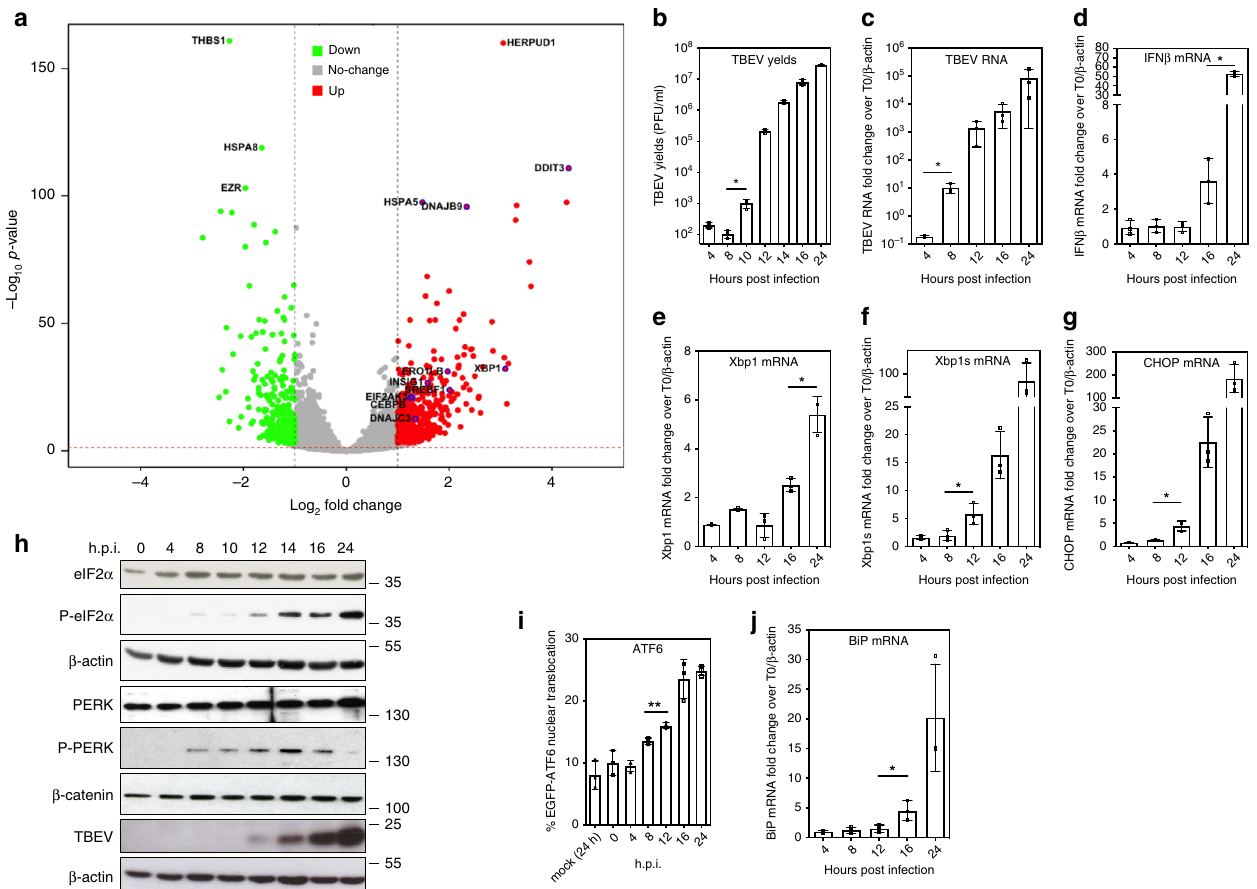
Fig. 1 Temporal analysis of the UPR response to TBEV infection. a Difference in total transcript expression following TBEV infection. Total RNA was extracted from TBEV infected cells at 0, 10, and 24 h.p.i. in triplicate independent experiments and processed for high-content sequencing ( ∼ 24.6 million reads for each time point). The volcano plot shows the differential gene expression at 24/0 versus 10/0 h.p.i. Horizontal and vertical dashed lines indicate cutoff values (FDR value of 0.05 corresponding to 1,30 Score and absolute logarithmic fold-change >2, respectively). Genes having a signi fi cant altered expression are emphasized in red (upregulated) and green (downregulated). Upregulated hits from the UPR pathway are encircled in blue. b Time course of viral yields. U2OS cells were infected with TBEV at moi = 1. Supernatant from infected cells were used to infect Vero cells to measure virus yields (PFU/ml). c – g , k Time course of viral RNA and UPR-related mRNAs. U2OS cells were infected as in b . Total RNA extracted at the indicated time points and used as template for qPCR using primers speci fi c for TBEV (5 ′ -NCR) ( c ). TBEV RNA ampli fi cation products were normalized to β -actin RNA and plotted as fold change from time 0. Data and statistics are plotted as in Fig. 1b. The same protocol was used to quantify mRNA of IFN β ( d ), Xbp1 ( e ), Xbp1s ( f ), CHOP ( g ), and BiP ( j ). h Time course of PERK activation. U2OS cells were infected with TBEV at moi = 1. At the indicated time points, the total protein content was extracted and subjected to immunoblotting with the indicated antibodies. j Time course of ATF6 translocation. Cells treated as in ( b ) were quanti fi ed for ATF6 nuclear translocation. GFP positive cells were manually counted for ATF6 nuclear translocation at each time point. The graph shows the results from two independent experiments, 200 cells for each time point. Typically three biologically independent experiments ( n = 3) in triplicate repeats were conducted for each condition examined. Average values are shown with standard deviation and p -values, measured with a paired two-tailed t -test. Signi fi cant p -values are indicated by asterisks (** p < 0.01; * p < 0.05). Source data are provided as a Source Data fi